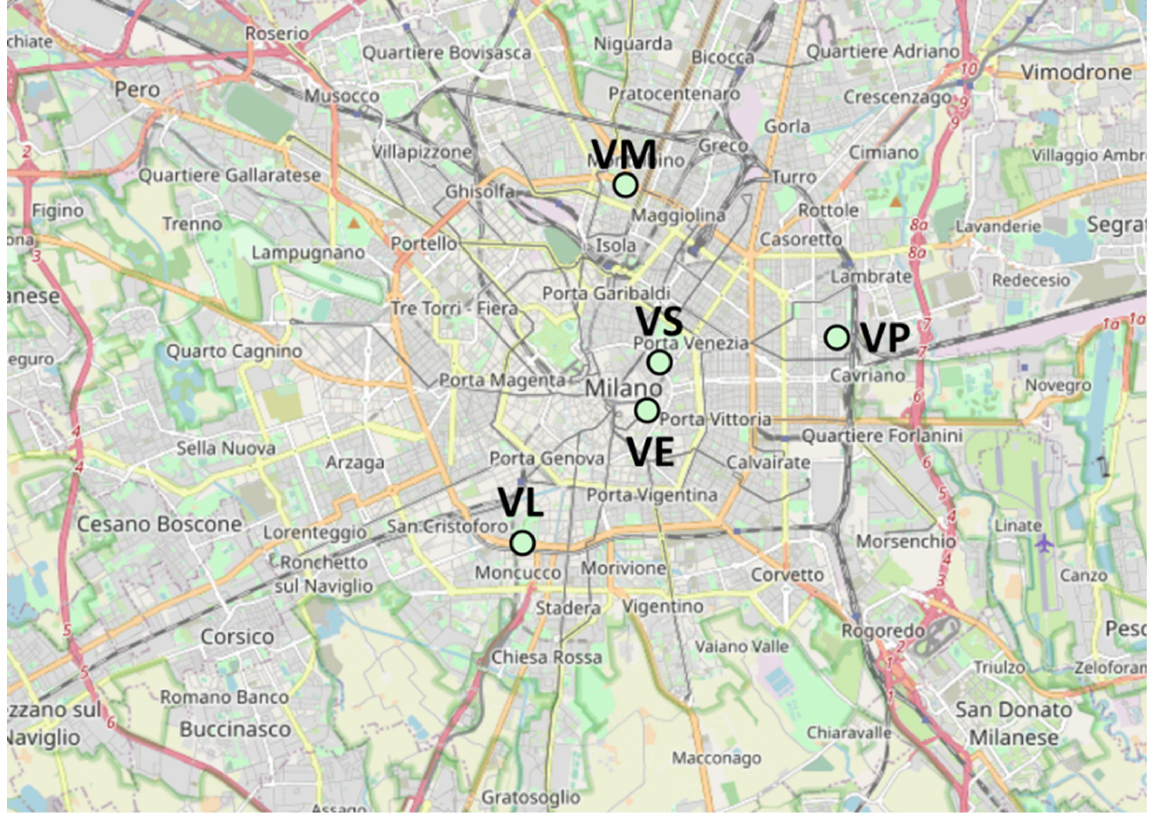
Table 1. ARPA Lombardia air quality monitoring stations characteristics.